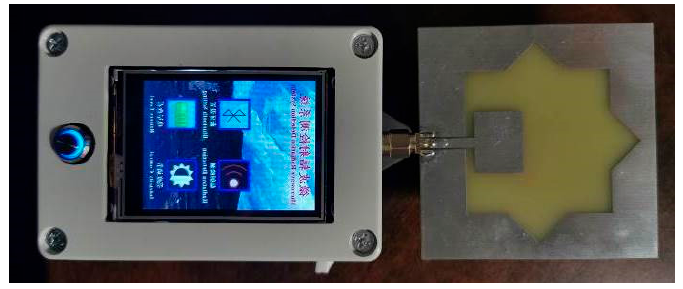
Figure 6. Photo of the microwave power detection system.